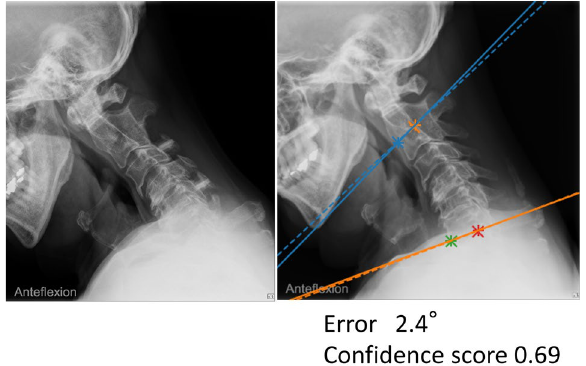
Figure 8. A case of correct measurement despite the presence of fused vertebrae. Left: before measurement. Right: after measurement. The solid lines represent the ground truth, and the dashed lines represent the measurement obtained by artificial